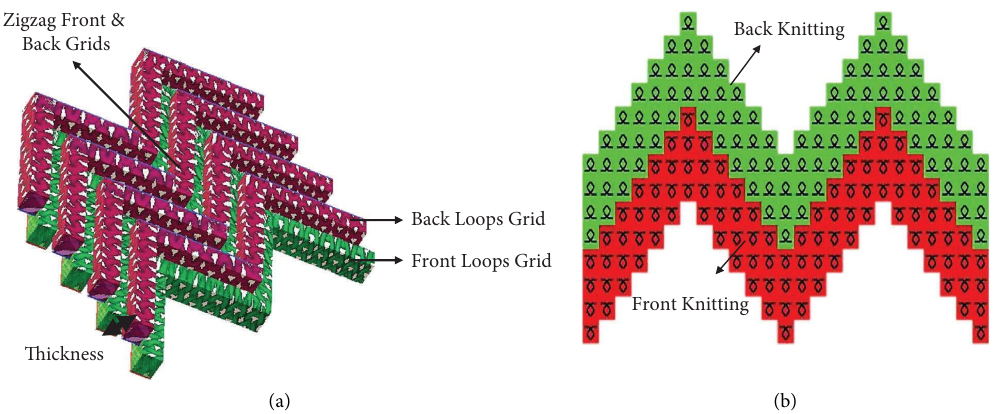
Figure 1: (a) 3D diagram of the zigzag structure and (b) knitting notation of zigzag structures.